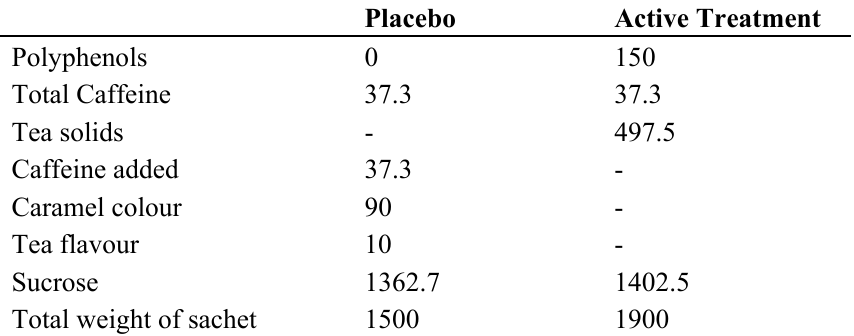
Table 1. Composition of the test products (mg per